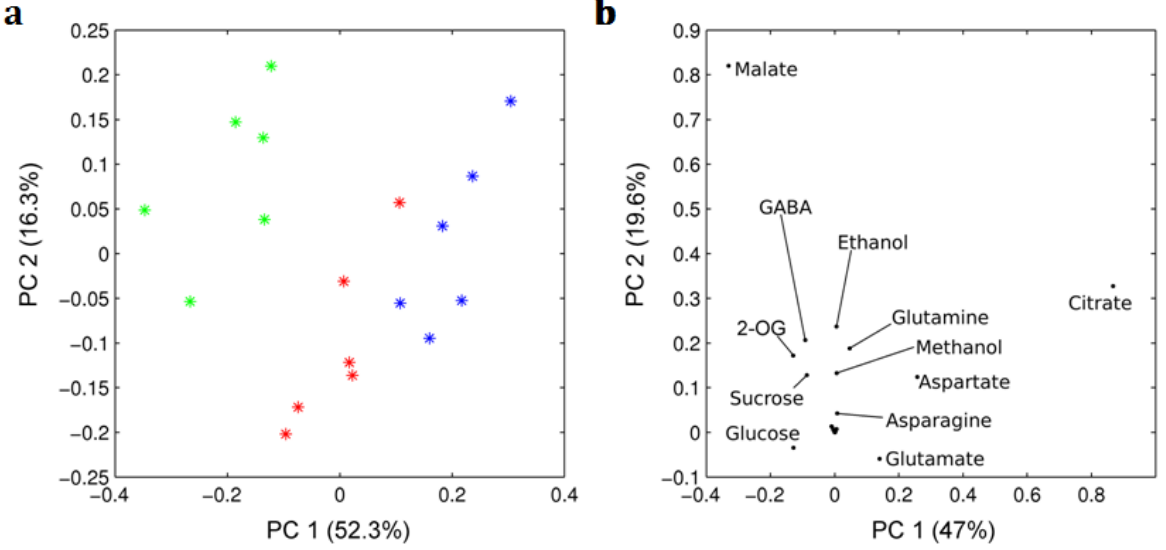
Figure 2. PCA analysis performed on metabolite concentrations for all the studied samples. Panels show ( a ) the scores plots, in which each point corresponds to one sample, and ( b ) the loading plots, in which each point is a metabolite concentration. Green, red and blue colors indicate maturation stage of fruits as described in Figure 1, and 2-OG indicates